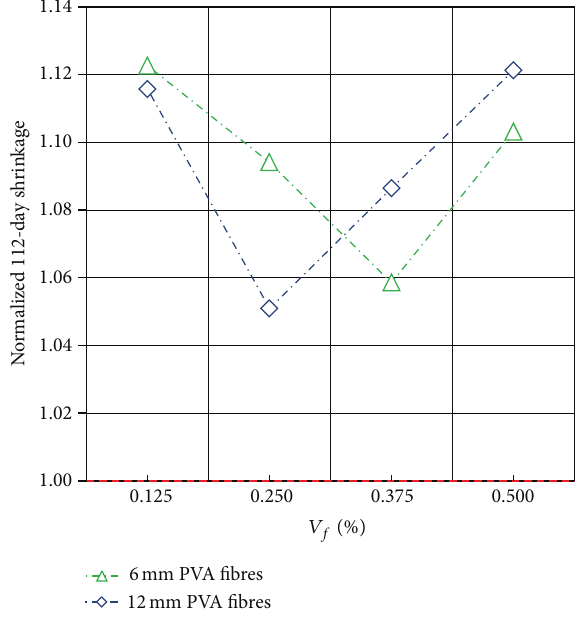
Figure 10: Normalized shrinkage of FRC at 28 days with respect to the control concrete.